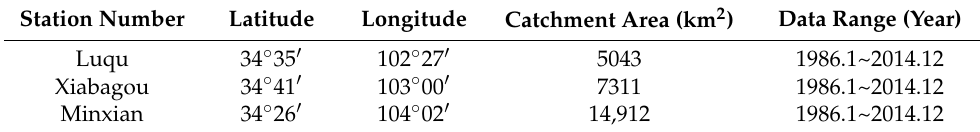
Table 2. Information of main hydrographic stations in the upper Taohe River